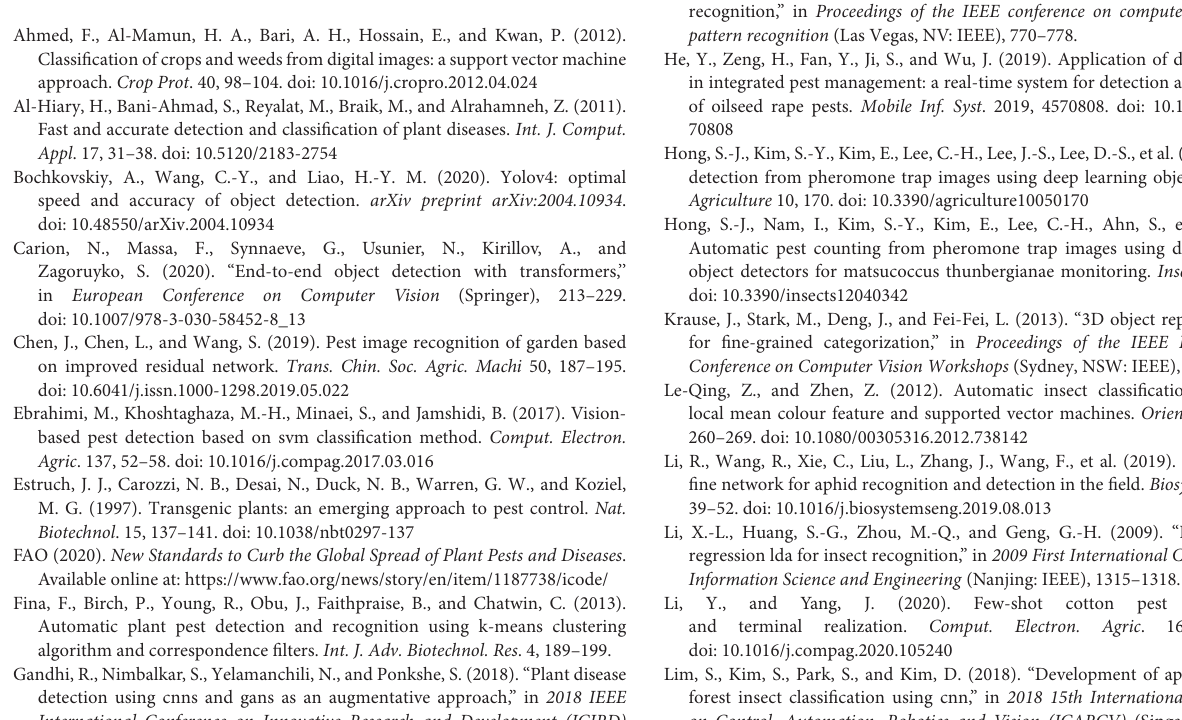
the follow-up to further improve the model’s ability to detect small